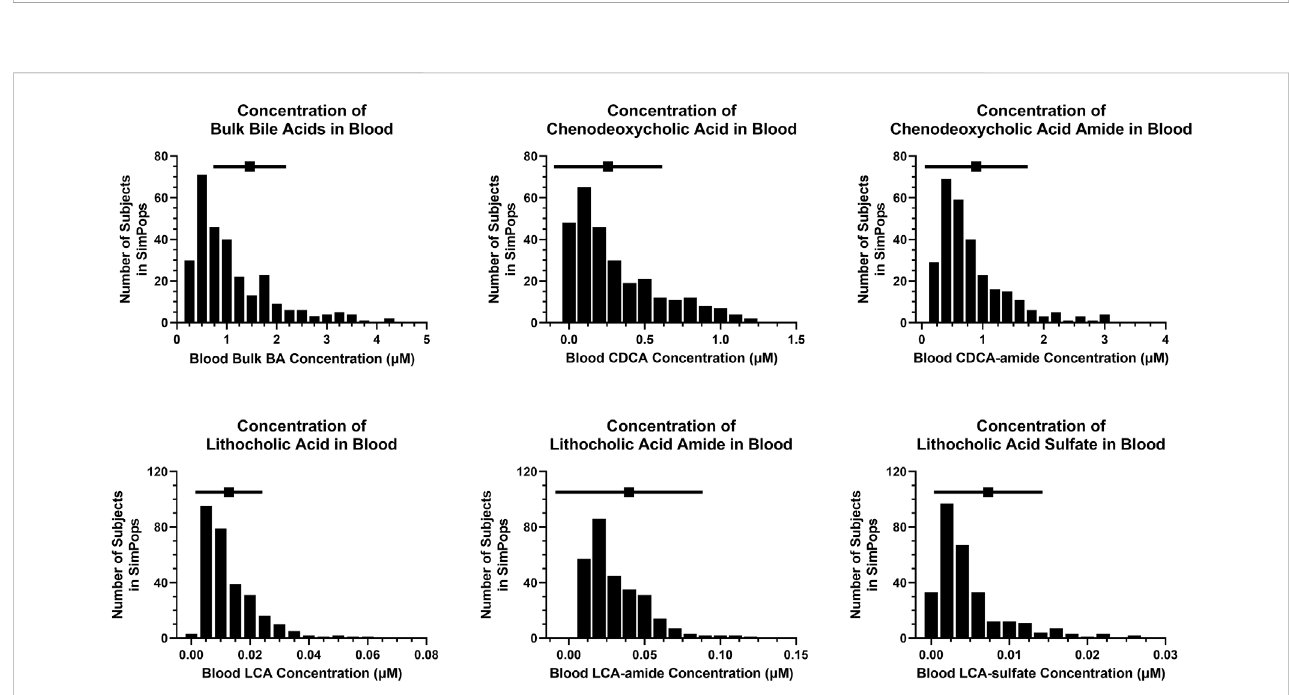
FIGURE 4 SimPopsdistribution ofbloodBAconcentrations. BA,bileacid;CDCA, chenodeoxycholic acid;LCA,lithocholicacid.Clinicallyobserved mean±SDdata are depicted by a solid square and horizontal line, respectively; however, circulating BA concentrations were not normally distributed (Trottier et al.,